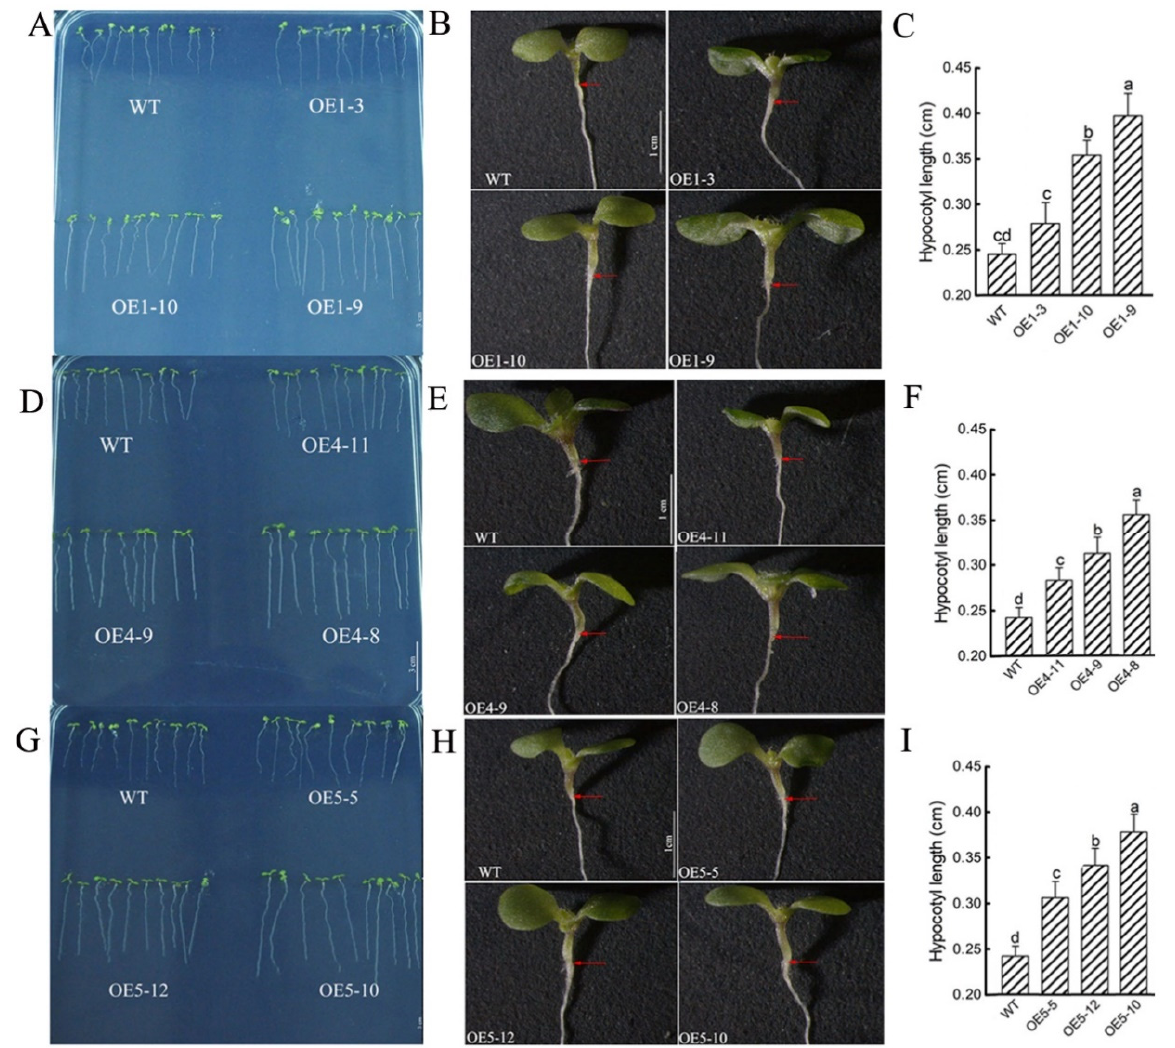
Figure 7. Hypocotyl development of Arabidopsis Col 35S:: ZmGA20ox1 , 35S:: ZmGA20ox4 and 35S:: ZmGA20ox5 . Values of hypocotyl length are means ± SD of 20 seedlings. Different letters indicate significant differences at p < 0.05 according to Duncan’s multiple range test. ( A – C ) Phenotypes and hypocotyl length of WT and OE ‐ ZmGA20ox1 (OE1 ‐ 3, 1 ‐ 10 and 1 ‐ 9); ( D – F ) phenotypes and hypocotyl length of WT and OE ‐ ZmGA20ox4 (OE4 ‐ 11, 4 ‐ 9 and 4 ‐ 8); ( G – I ) phenotypes and hypocotyl length of WT and OE ‐ ZmGA20ox5 (OE5 ‐ 5, 5 ‐ 12 and 5 ‐ 10).